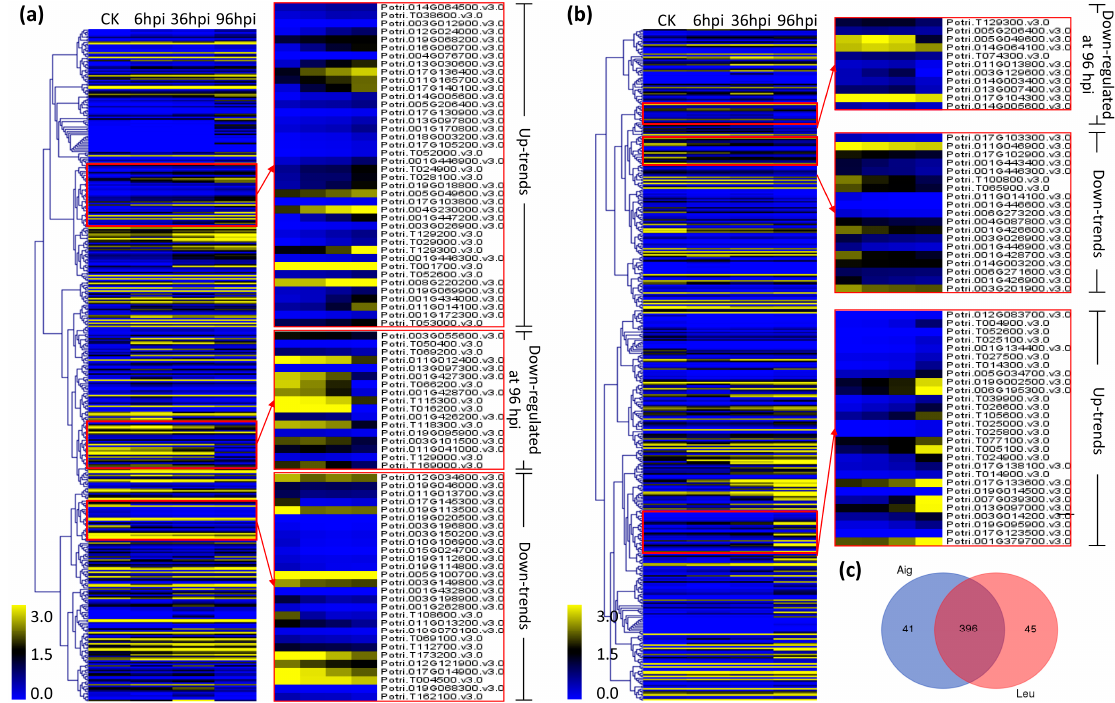
Figure 9. Clustering of gene expression of genes annotated with disease resistant gene in two poplar sections: ( a ) clustering result of Aig; and ( b ) clustering result of Leu. The clustering is finished using hierarchical analysis according to values of log 2 (FPKM + 1) for each disease resistant gene. The clustering is performed on Multiple Experiment Viewer (MeV). The row of heat map represents a gene and the column represents an infection stage. The expression level of genes involved in “up-trend” keep increasing as the disease development. The expression level of genes involved in “down-trend” keep decreasing as the disease development. The expression of genes involved in “down-regulated at 96 hpi” sharply deceased at 96 hpi compared with 36 hpi. ( c ) Venn diagram shows the overlapping disease resistant genes between Aig and